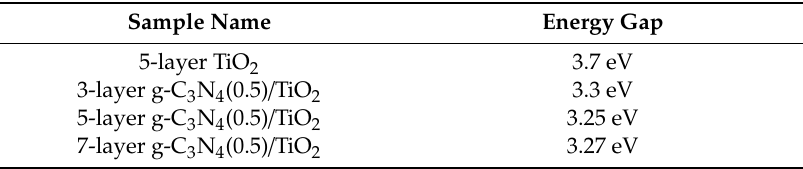
Figure 4. ( A ) Ultraviolet-visible diffuse reflectance spectrum (UV-vis DRS) of 5-layer TiO 2 thin film and different layers of g-C 3 N 4 (0.5)/TiO 2 ; ( B ) The bandgap curve after conversion of the Tauc formula. Table 1. The energy gaps of prepared samples.